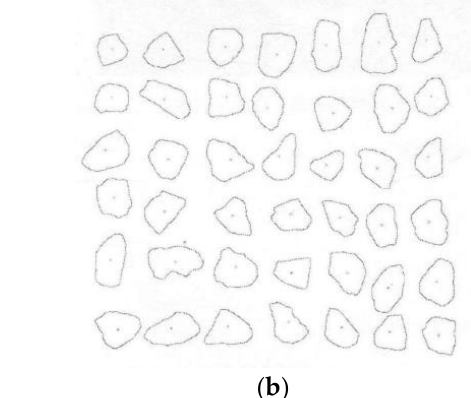
description; ( b ) processed photos of the coarse aggregate used for parameter calculations.